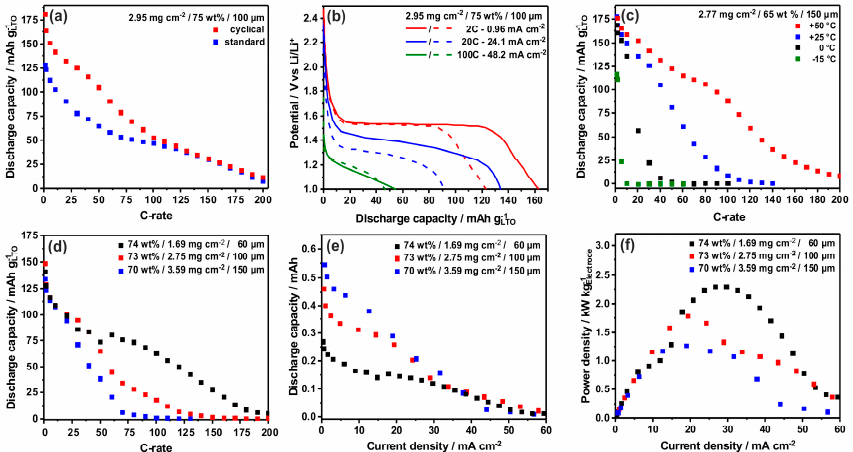
Figure 6. ( a ) Galvanostatic rate test up to 200 C of 70 wt % LTO–VACNT half-cells synthesized via cyclic and standard method. ( b ) Voltage profiles of cyclic (solid line) and standard (dashed line)